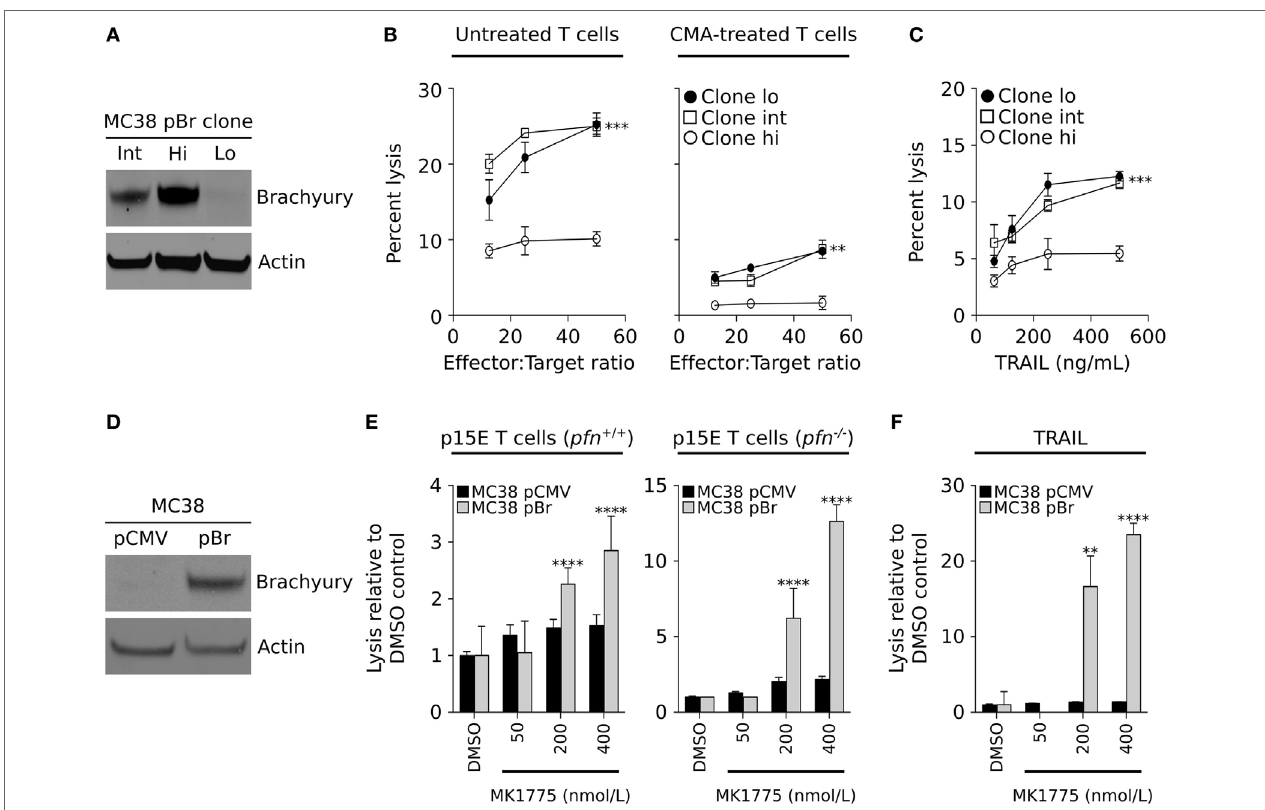
FigUre 5 | WEE1 inhibition improves the sensitivity of brachyury high/p21-low carcinoma cells. (a) Western blot analysis of brachyury expression in three clonally derived MC38 cell populations expressing low (Lo), intermediate (Int), or high (Hi) levels of the human brachyury transgene. (B) Sensitivity to lysis by p15E-specific cytotoxic CD8 + T cells, which have been left untreated (left panel) or were pre-treated with CMA to inhibit their ability to lyse targets in a perforin-dependent manner (right panel). (c) Sensitivity of MC38 clones to indicated doses of recombinant TNF-related apoptosis-inducing ligand (TRAIL). (D) Western blot analysis of brachyury expression in the MC38 pCMV and pBr isogenic cell pair. (e) Lysis of the MC38 tumor pair following WEE1 inhibition with indicated doses of MK-1775 by p15E-specific T cells (E:T ratio 50:1) expanded from either wild-type mice (left panel) or perforin-deficient animals (right panel), or (F) TRAIL (125 ng/mL). The data depicting the lysis of the MC38 pCMV and pBr cell lines are representative of two independent experiments.